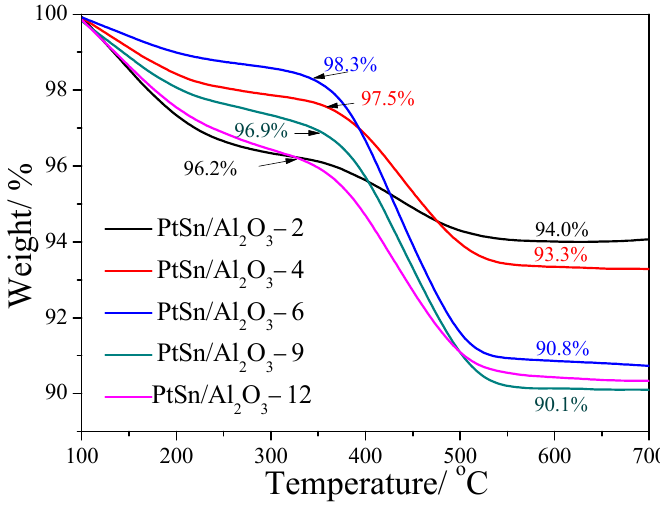
Figure 9. TG curves of PtSn/Al 2 O 3 catalysts after reaction for 6